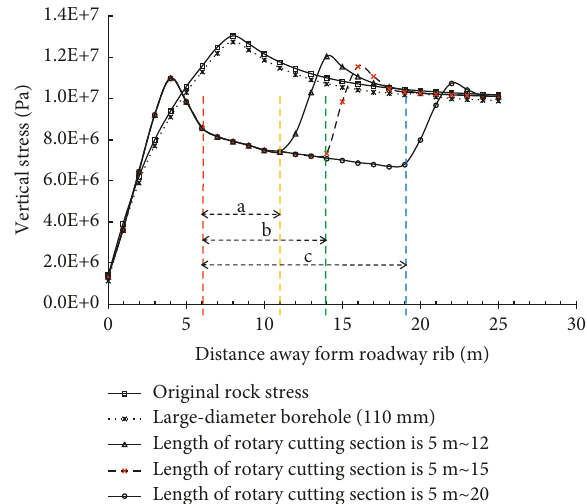
Figure 17: The vertical stress distribution laws under different lengths of rotary cutting section. Note: a , the length of pressure relief zone is 5m; b , the length of pressure relief zone is 8m; c , the length of pressure relief zone is 13m.